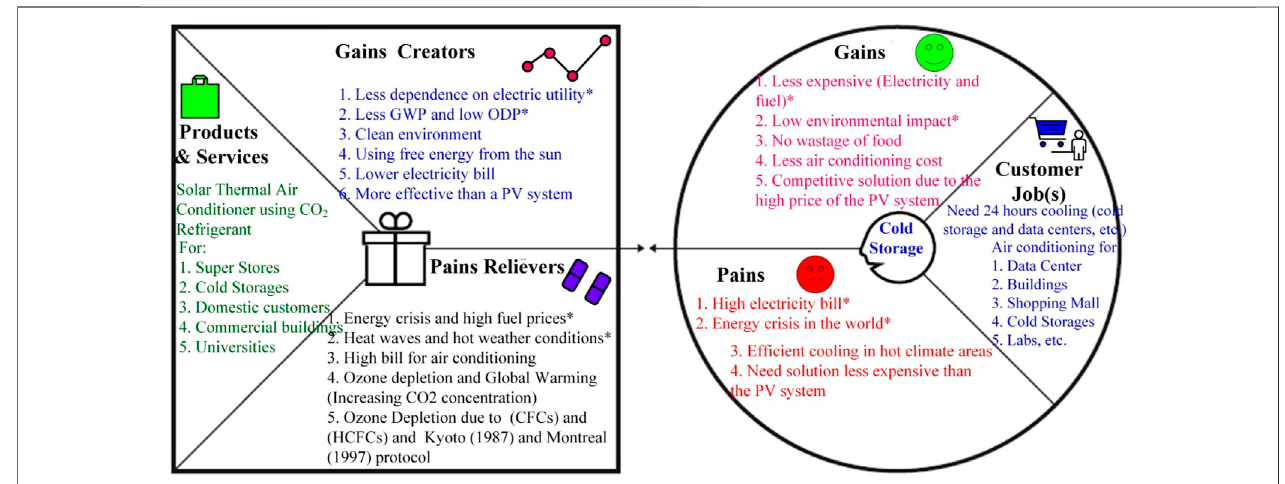
FIGURE 10 | The VPC for the solar thermal cooling adapted from (Osterwalder et al., 2014; Strategyzer A. G., 2018).